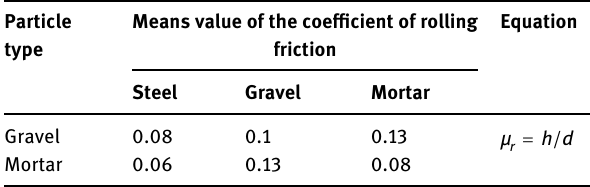
Table 5: Coe ffi cient of rolling friction of gravel and mortar Particle